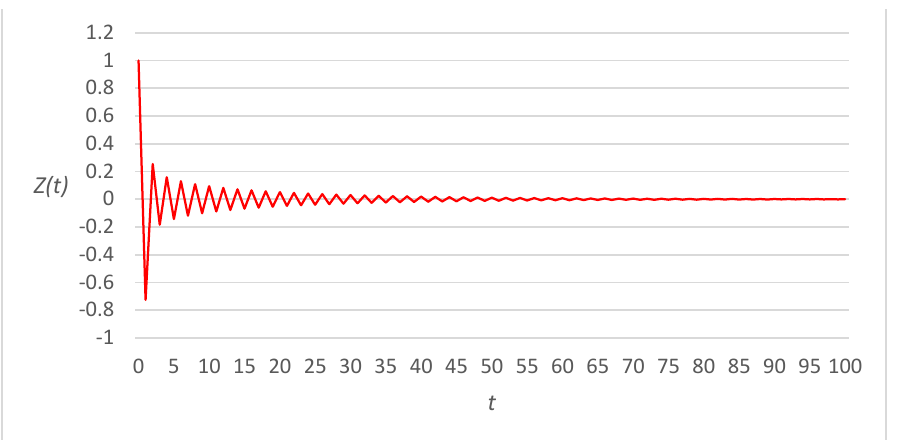
Figure 2. Time evolution of dynamical system for α = 0.75; β = 0.75; γµ = 10; ϕ = 0.23; Z ( 0 ) = 1 (case of linear link cost functions).